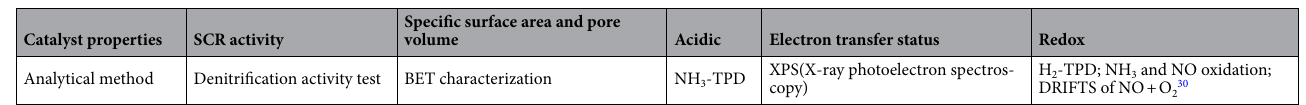
Table 4. Research methods of ABS influence on